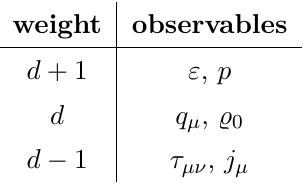
Table 1 . Conformal